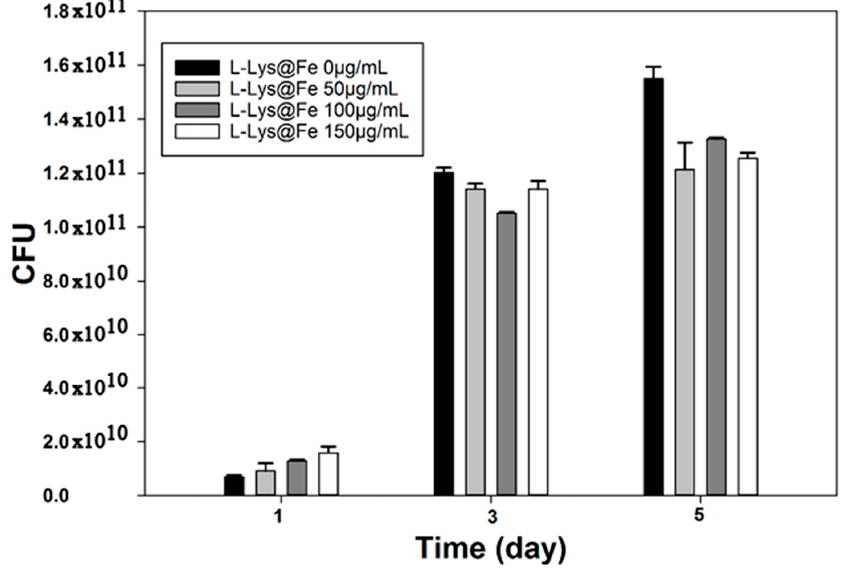
Figure 7. Bacillus subtilis natto cells growth at different at L -lysine-IONs concentrations.